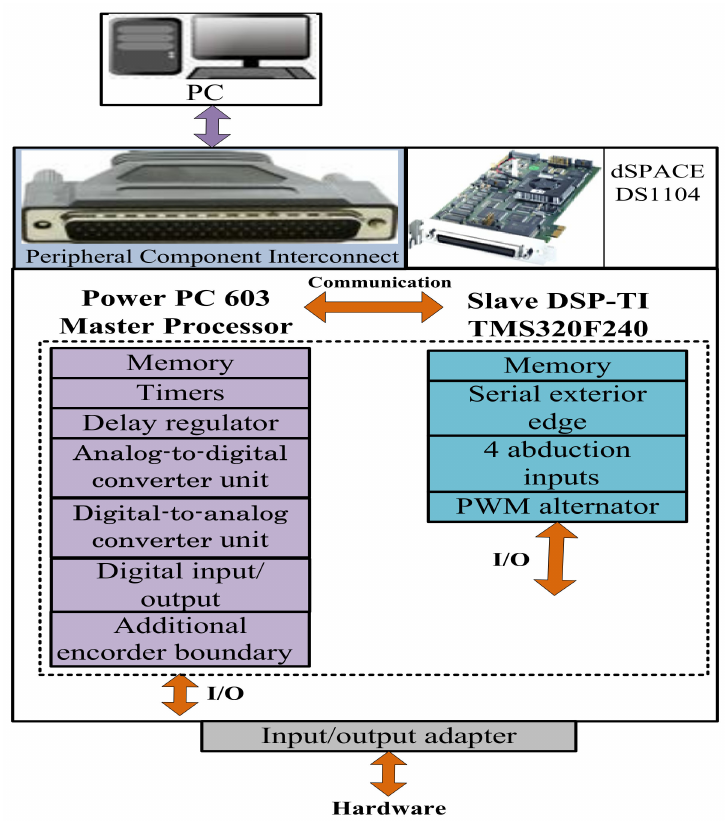
Figure 4. Structure of the dSPACE DS1104 controller